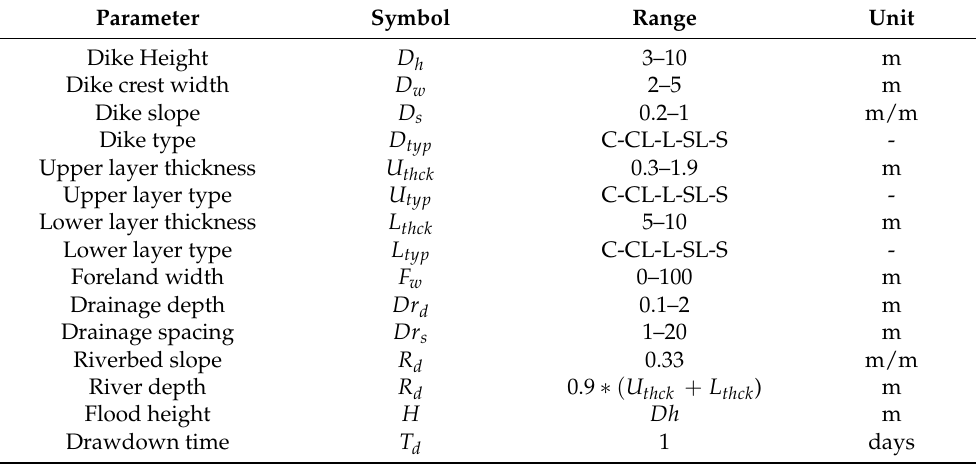
Figure 1. Schematization of model inputs, indicating the setup of the hydrological model. See for their meaning, values and possible ranges Tables 1 and 2. Table 1. Name, symbol and range of the model parameters. A visualization of each of the parameters is shown in Figure 1. Layer type descriptions are found in Table